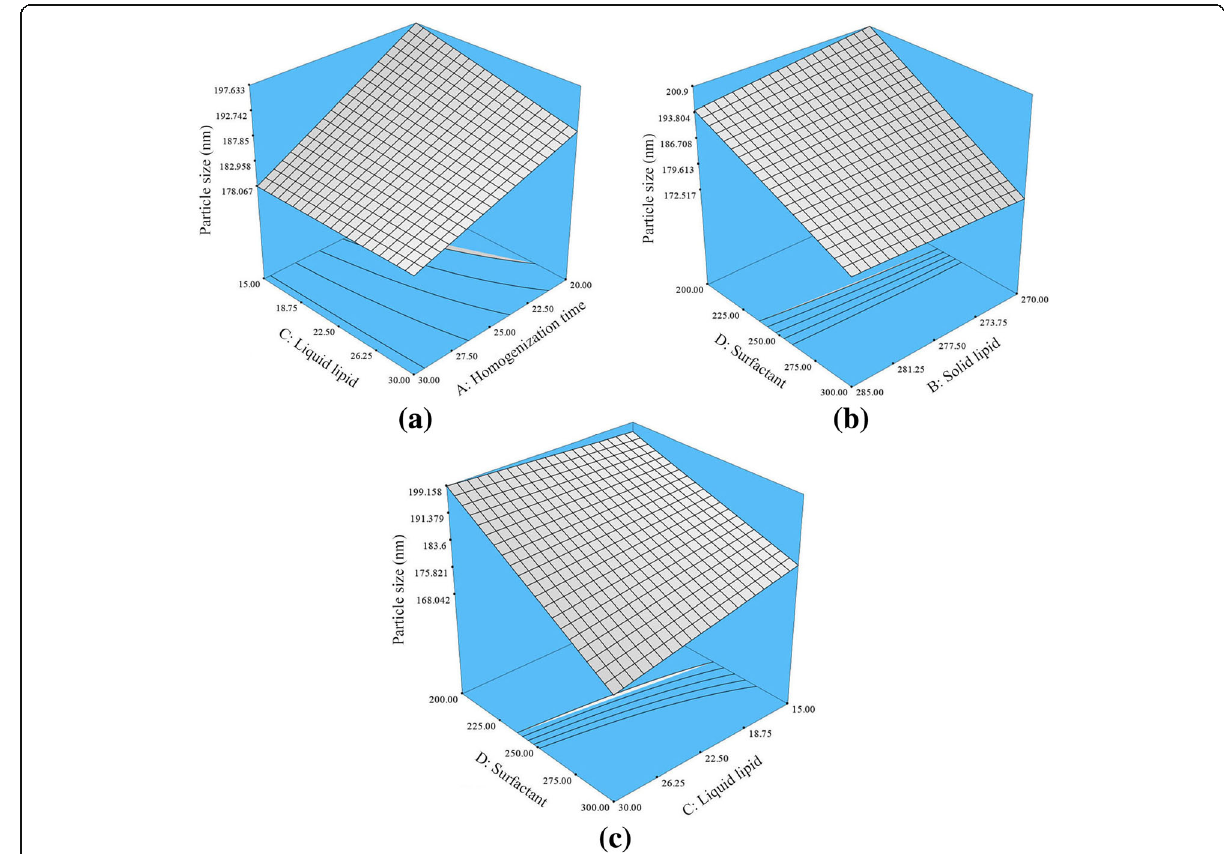
Fig. 2 Response surface plot depicting the significance ( p <0.05) effect of homogenization time, liquid lipid concentration, surfactant concentration, and interaction between a AC, b BD, and c CD on the PS of HVD-NLCs. A homogenization time, B solid lipid, C liquid lipid, D